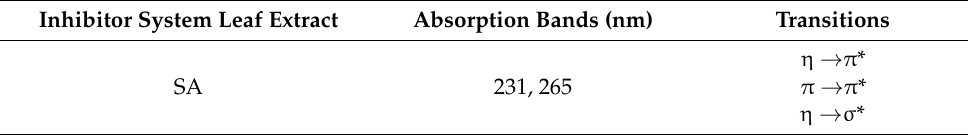
Table 2. UV-visible spectral absorption bands (nm) of aqueous extract SA